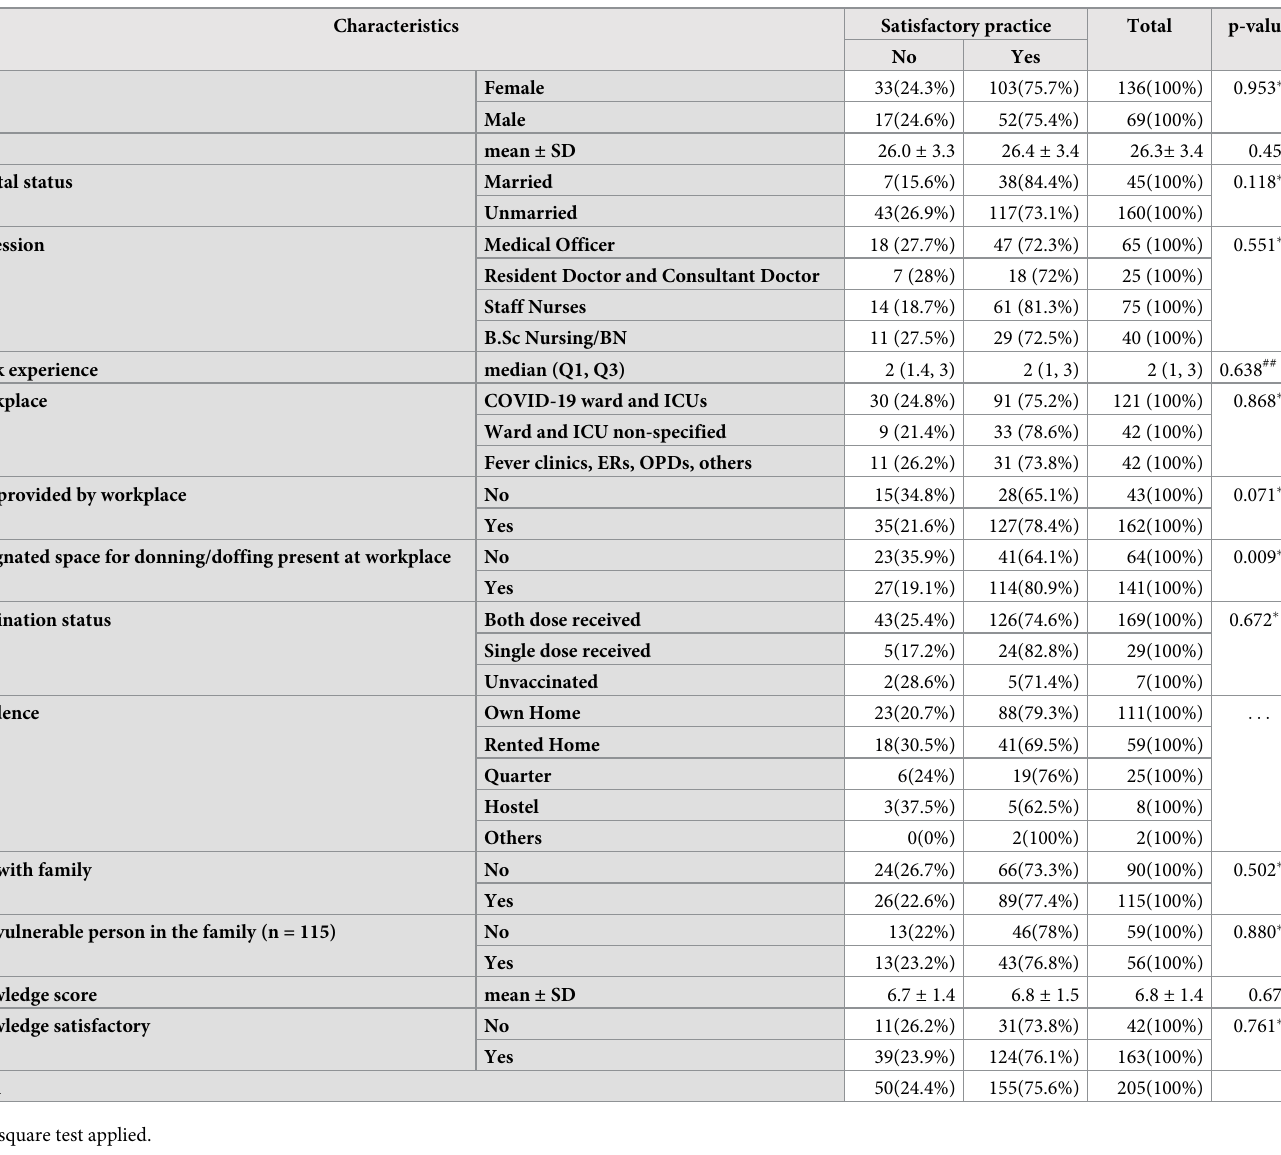
Table 5. Crosstabulation of factors with satisfactory practice scores (n =